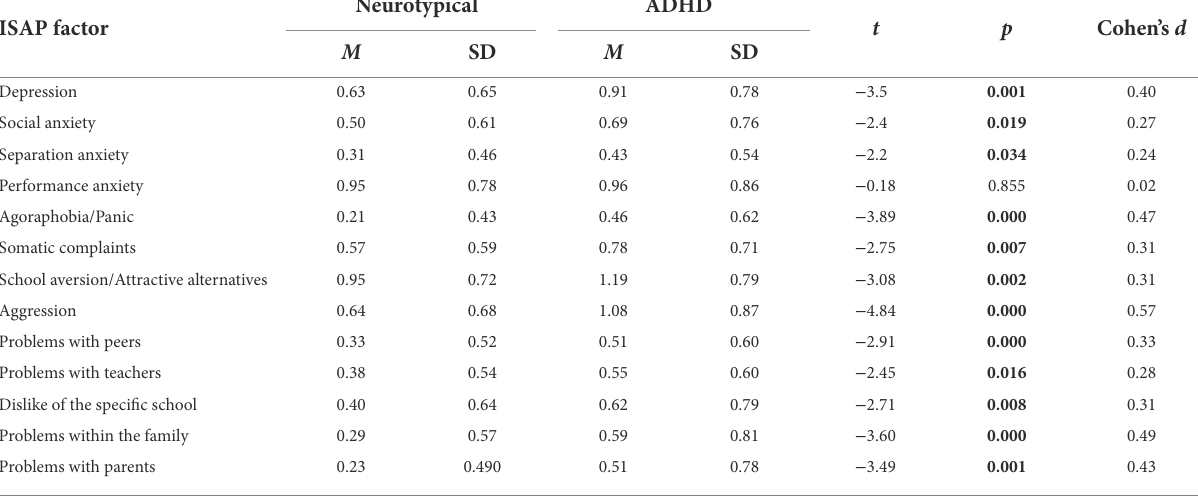
TABLE 2 Means, standard deviations and differences in symptom level between adolescents with or without attention deficit hyperactivity disorder (ADHD).